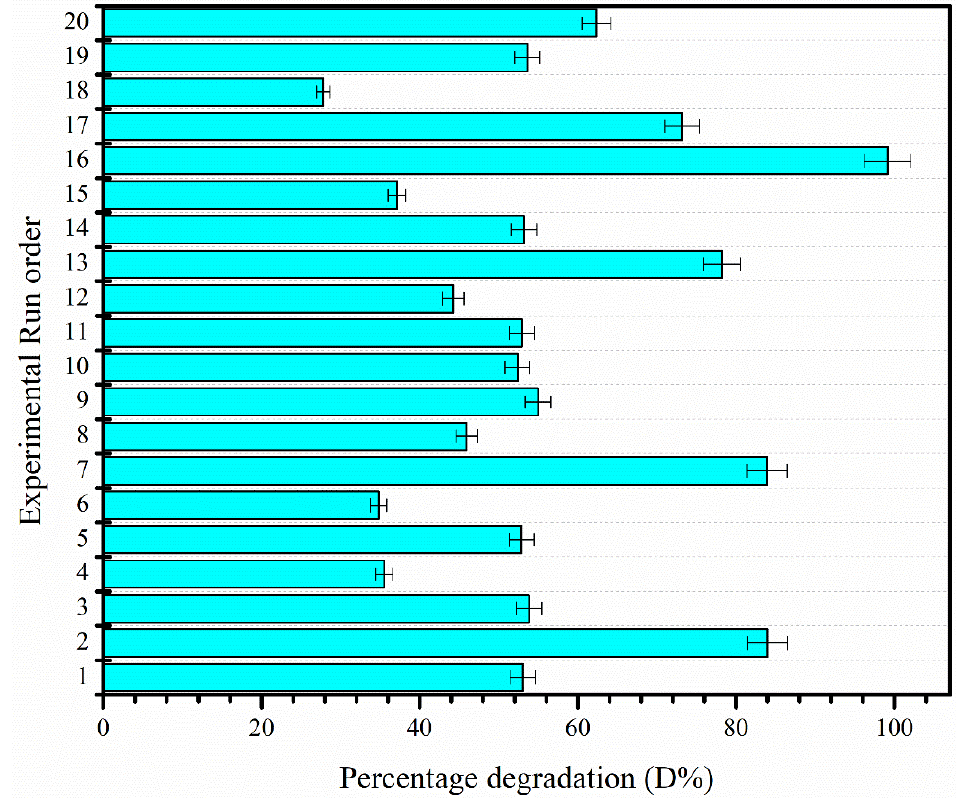
Figure 8. The CCD-based twenty photocatalytic reactions for the degradation of MO performed under the reaction conditions specified by the standard 3-factor RSM design of experiment.